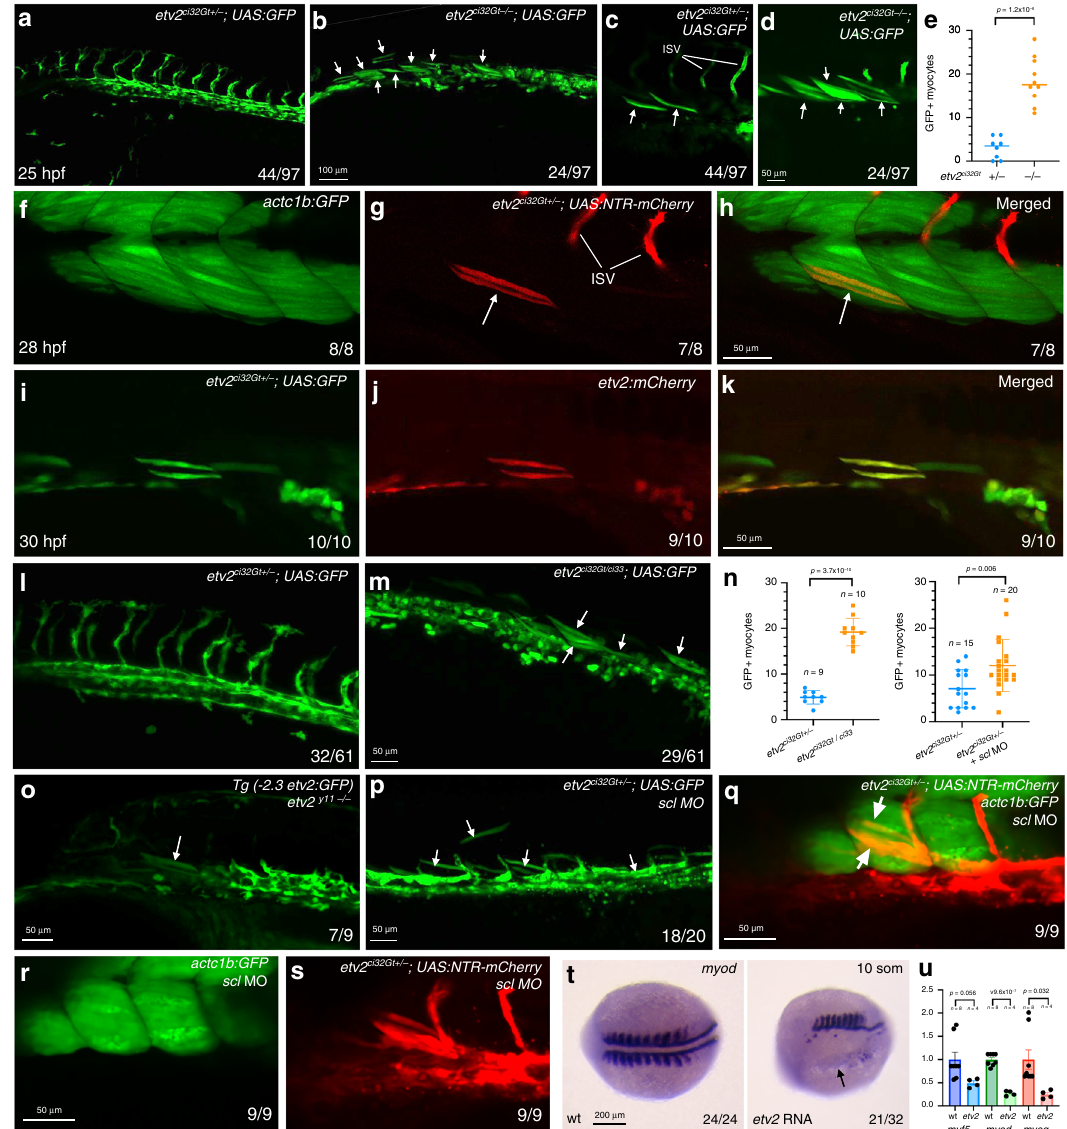
Fig. 3 Etv2- expressing cells differentiate as skeletal muscle cells in the absence of etv2 function. a – d Trunk region of etv2 ci32Gt ; UAS:GFP embryos at 25 hpf. Maximum intensity projections of selected confocal slices are shown in ( c , d ). Note the absence of intersegmental vessels (ISVs) and elongated GFP-positive skeletal muscle fi bers (arrows, c , d ). The embryos were obtained from an incross of heterozygous etv2 ci32Gt carriers; embryo numbers (lower right) correspond to the expected Mendelian ratio. e Quanti fi cation of GFP + myocytes in the trunk region of 8 etv2 ci32Gt + / − and 10 etv2 ci32Gt − / − ; UAS:GFP embryos at 25 hpf, analyzed in 2 replicate experiments. The bars show median values. f – h Co-expression of etv2 ci32Gt + / − ; UAS:NTR-mCherry and muscle- speci fi c actc1b:GFP in mCherry-positive muscle cells (arrows, g , h ). i – k The Tg(etv2:mCherry) line shows mCherry expression in skeletal muscle cells when crossed to etv2 ci32Gt + / − ; UAS:GFP carriers. l , m Multiple GFP + skeletal muscle cells are apparent in the progeny of etv2 ci32Gt + / − ; UAS:GFP zebra fi sh crossed with the etv2 ci33 + / − line, which carries a loss-of-function mutation in etv2 . Note that the expected frequency of double heterozygous embryos in ( m ) is 50%. n Quanti fi cation of GFP + myocytes in the trunk region of etv2 ci32Gt/ci33 and etv2 ci32Gt + / − ; scl MO embryos shown in ( m , p ) obtained in two replicate experiments. The graphs show median and SD values. o GFP + skeletal muscle cells observed in etv2 y11 − / − embryos crossed into the Tg(-2.3 etv2: GFP) reporter line. p Multiple GFP + skeletal muscle cells are apparent in etv2 ci32Gt + / − ; UAS:GFP embryos injected with scl MO. See graph n for quanti fi cation. q – s Ectopic myocytes observed in scl MO-injected etv2 ci32Gt + / − ; UAS:NTR-mCherry embryos are positive for muscle-speci fi c actc1b:GFP expression at 24 hpf. t etv2 RNA overexpression inhibits myod expression (arrow). Dorsal view, anterior is to the left. u qPCR analysis of myf5 , myod ,